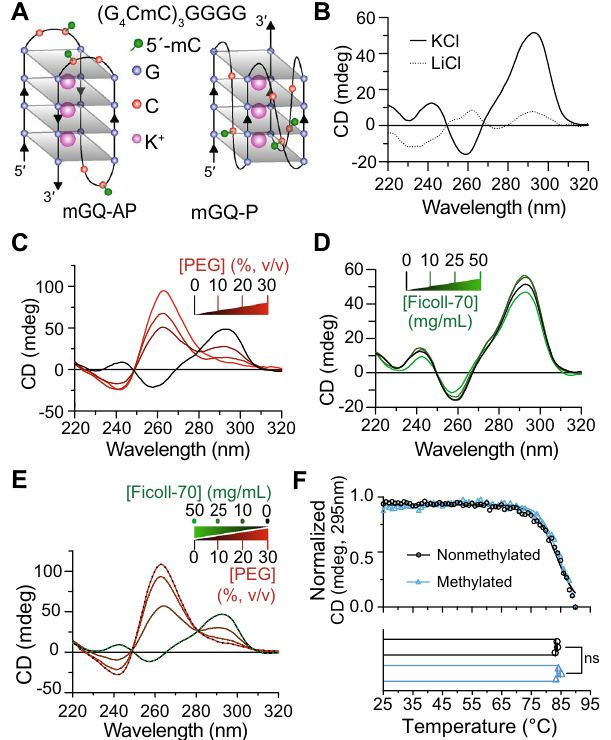
Figure 2. CpG hypermethylation of C9-NRE DNA has minimal effects on GQ topological distributions or stability. ( A ) Representation of methylated antiparallel (mGQ-AP) and parallel (mGQ-P) GQ examined using a methylated C9 -22mer (m C9 -22mer). The green spheres denote the three locations of 5-methylcytosine (5mC) CpG modifications on the mC9-22mer. ( B ) Representative plot for CD spectra for 10 µM of the m C9 -22mer in the presence of 100 mM KCl (solid line) or 100 mM LiCl (dotted line) at 25 °C. ( C ) Representative plots are shown for CD spectra for 10 µM of the m C9- 22mer in the presence of 100 mM KCl and increasing molecular crowding agent of 0, 10, and 20% [PEG-200] (v/v) are depicted by the black to red line transition. ( D ) CD spectrum for the mC9-2mer in the presence of increasing molecular crowding agent 0, 10, 25, and 50 [Ficoll-70] (mg/mL) are denoted by the black to green line transition. ( E ) Representative CD spectra for the m C9 -22mer are shown in the presence of decreasing [Ficoll-70] combined with increasing [PEG-200]. ( F ) Melt comparison of 10 µM nonmethylated ( C9 -22mer, black line and empty circles) and methylated (m C9 -22mer; cyan line and triangles) C9 -22mer in the presence of 100 mM KCl are plotted. Circles denote the average value with lines showing the sigmoidal fit to the averaged data. The 295 nm wavelength was measured at a temperature range of 25–90 °C. The bar graph below shows the calculated melting temperature (T m ) obtained from the sigmoidal fits as the mean ± SEM for n = 3 with a non-significant (NS) p -value =